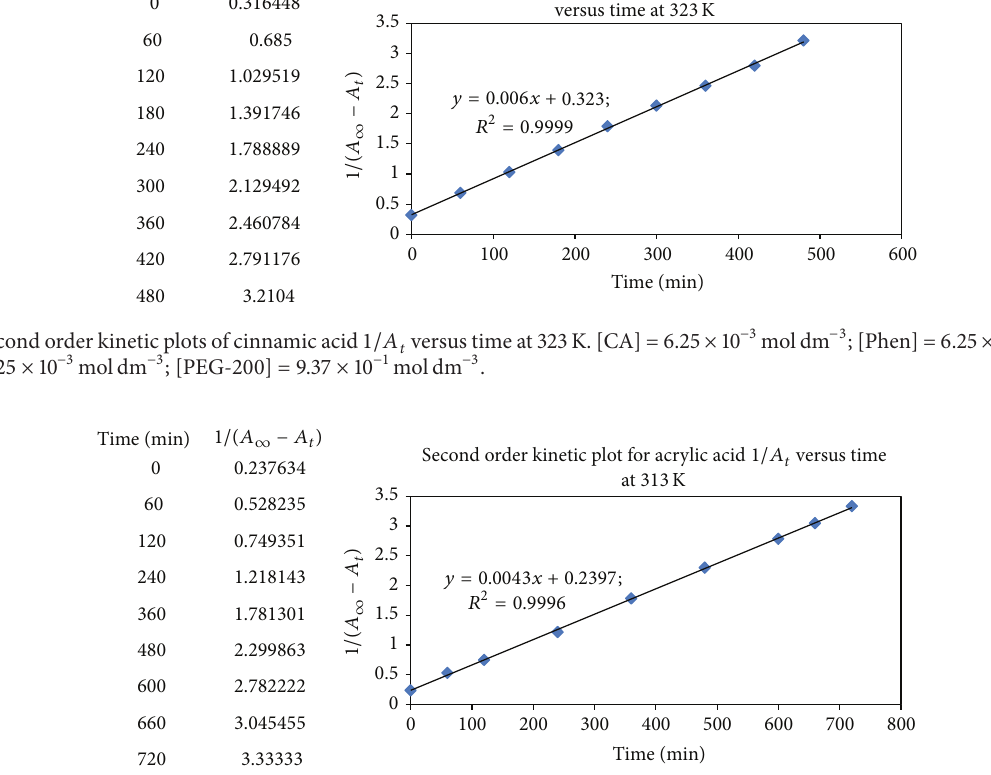
Figure 4: Second order kinetic plots of acrylic acid 1/𝐴 𝑡 versus time at 313K. [AA] = 6.25 × 10 −3 moldm −3 ; [Phen] = 6.25 × 10 −3 moldm −3 ; [Fe(III)] = 1.25 × 10 −3 moldm −3 [PEG-200] = 6.24 × 10 −1 moldm −3 .